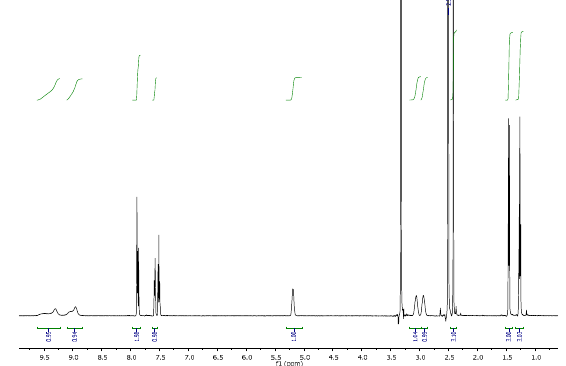
Figure 11. 1 H NMR spectrum of M DPT ( 2 ); 500MHz, DMSO-d 6 , RT.